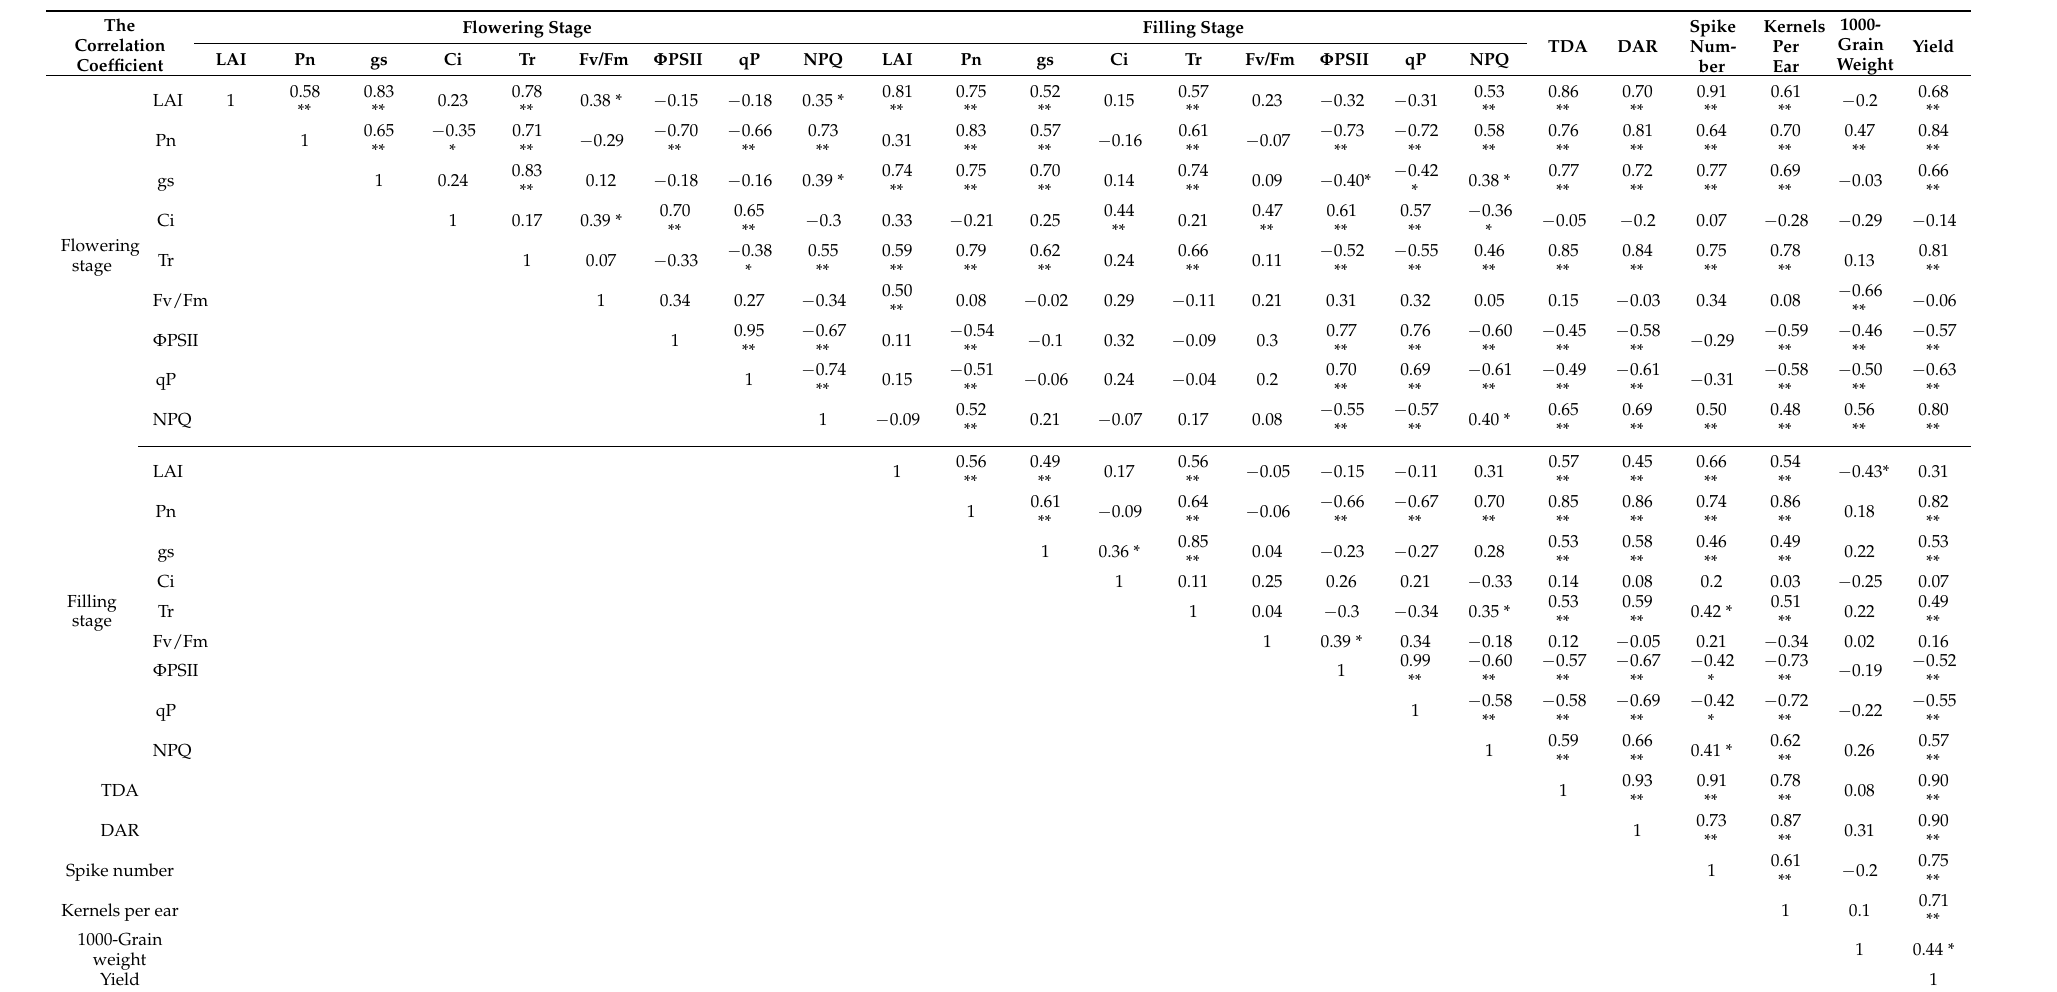
Table 5. Correlation coefficients of yield with photosynthetic parameters, dry matter accumulation and yield